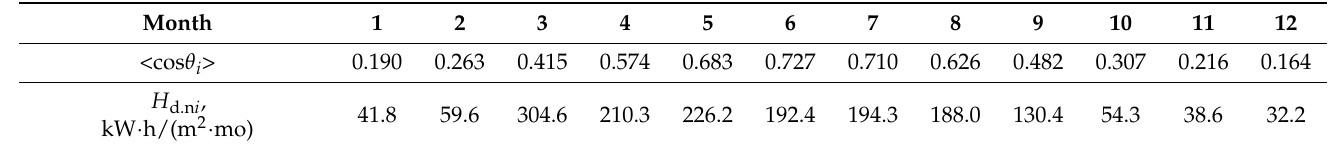
Table 7. Average monthly angle of inclination and monthly direct solar irradiation on